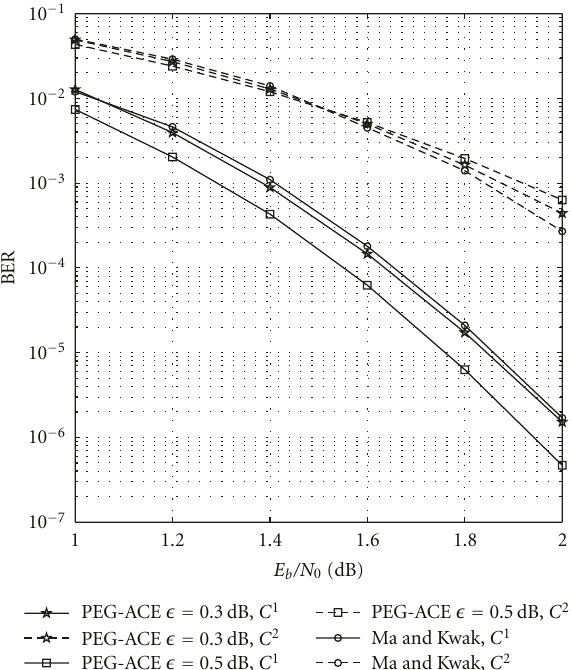
Figure 5: BER performance of the PEG-ACE (cid:2) = 0 . 5 dB code and the code designed by Ma and Kwak [6] after 10 decoder iterations. Both codes have n = 2048 and d v max = 20.